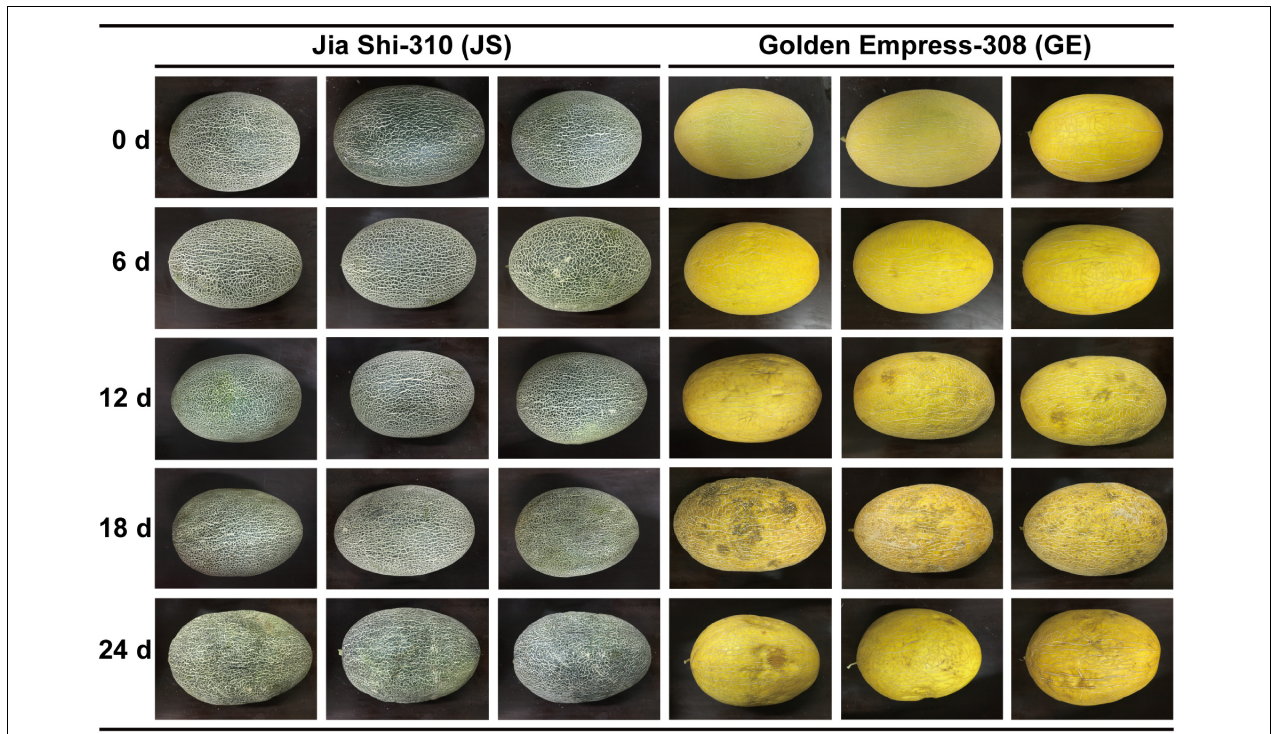
FIGURE 11 | Different cold tolerance between “Jia Shi-310” (JS) and “Golden Empress-308” (GE), and experimental